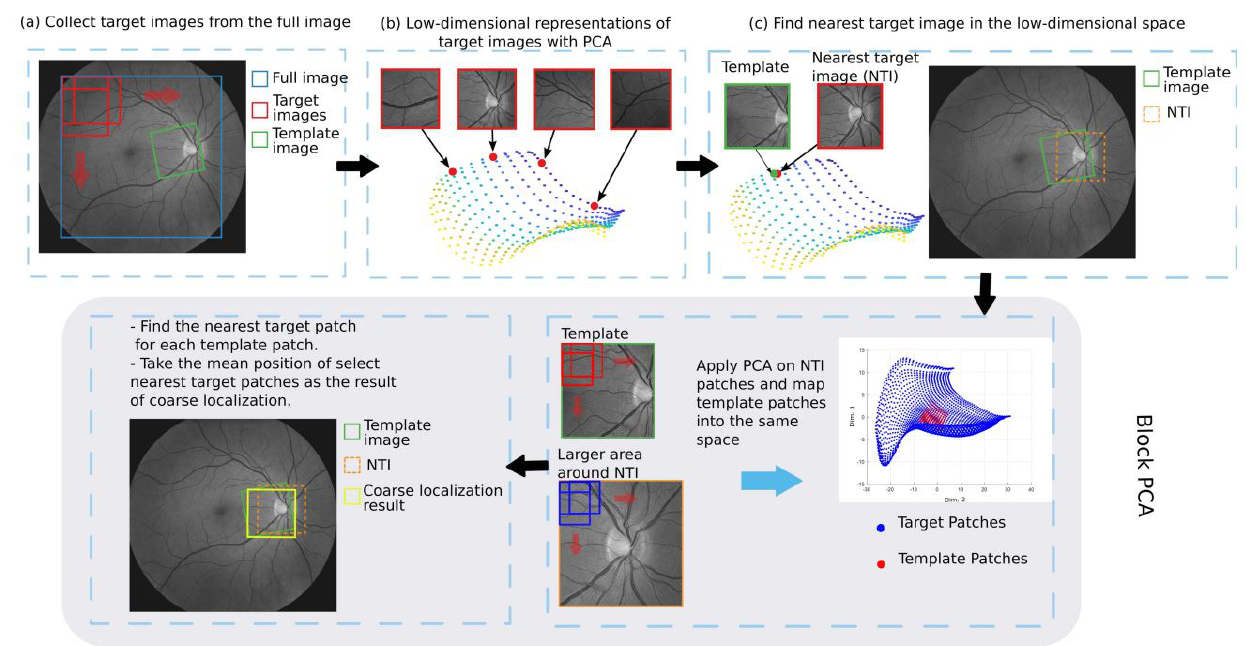
Figure 23. Details of RetinaMatch presented in